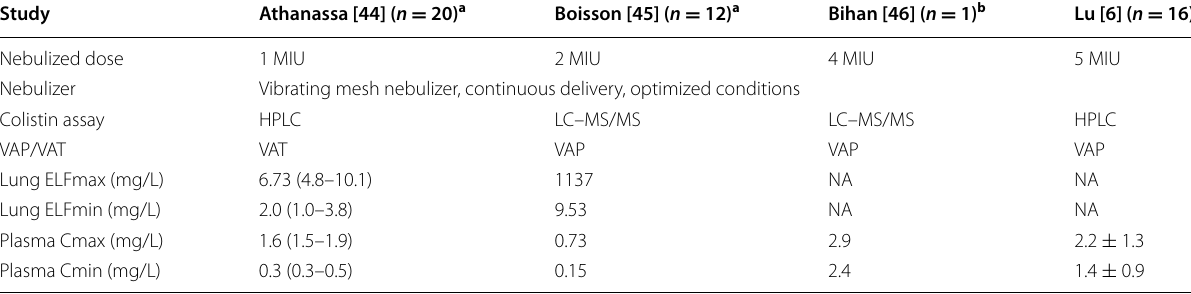
Data are presented as mean SD, medians (25–75% interquartile) or maximum and minimum values ± HPLC High-performance liquid chromatography, VAP ventilator-associated pneumonia; VAT ventilator-associated tracheobronchitis, ELF epithelial lining fluid, LC–MS/ MS liquid chromatography–tandem mass spectrometry, Cmax maximum plasma concentration, Cmin minimum plasma concentration a Blood sampled after the first dose; b blood sample performed at steady-state